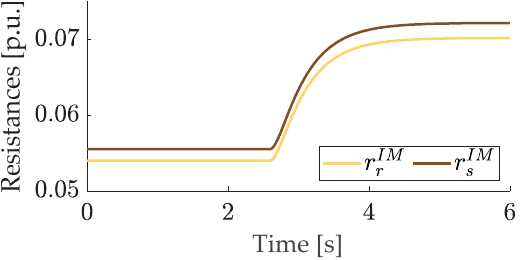
Figure 10. Assumed changes of rotor and stator resistances in IM model.